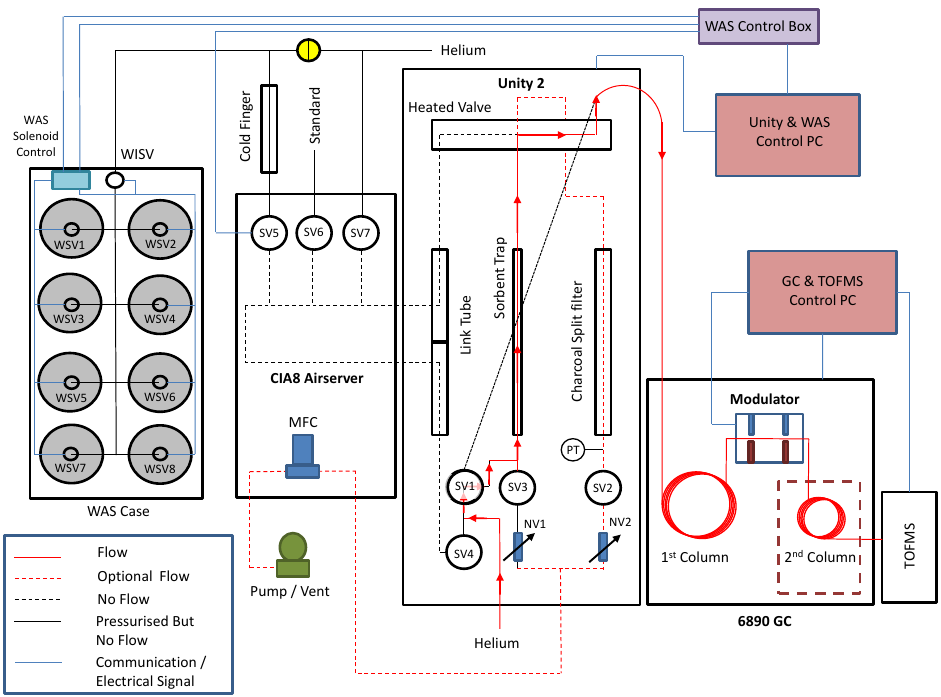
Figure 2. Schematic of the finalised TD-GC × GC-TOFMS sampling setup. SV stands for solenoid valve, NV for needle valve, MFC for mass flow controller, WISV for WAS inlet solenoid valve, WSV for WAS solenoid valve, and PT for pressure